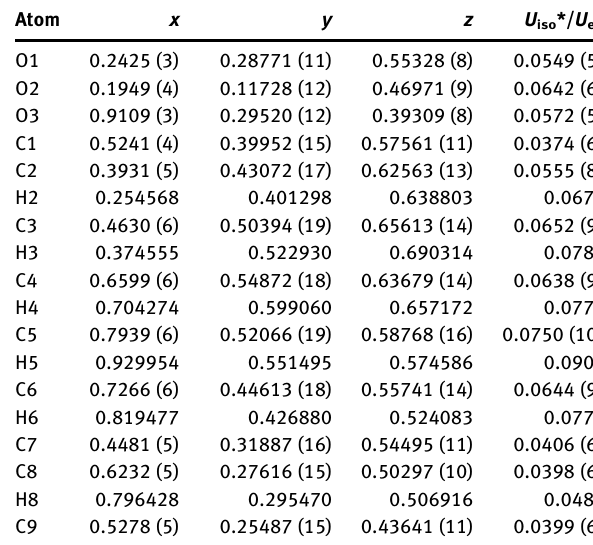
Table  : Fractional atomic coordinates and isotropic or equivalent isotropic displacement parameters (Å 